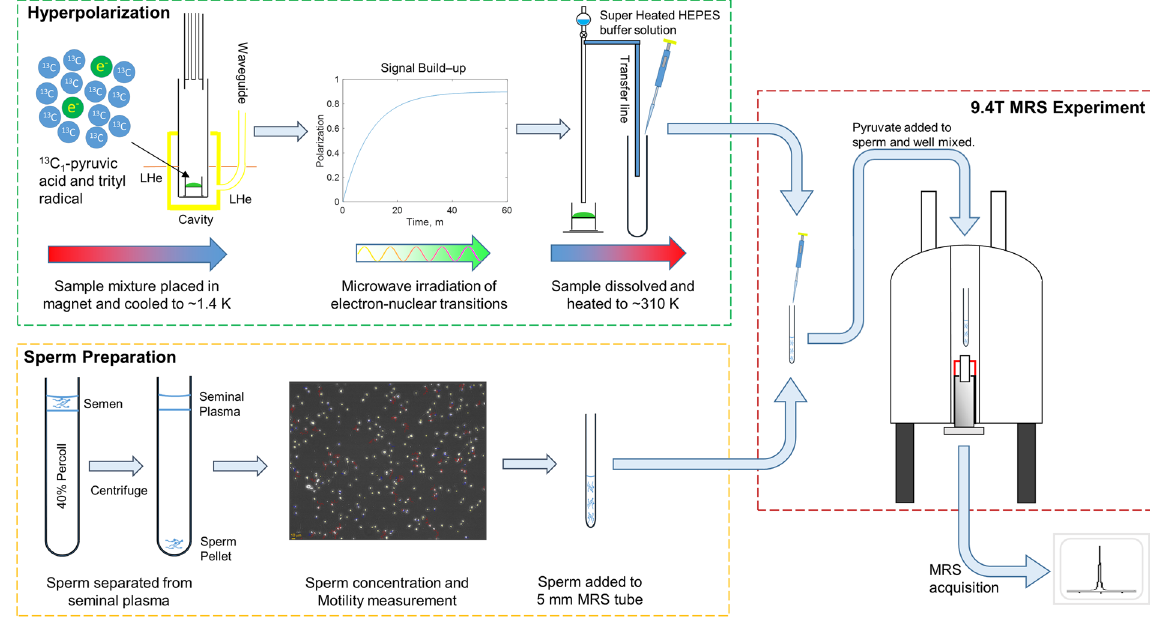
Figure 2. Outline of the methods used for administering hyperpolarized substrates to live sperm. The method consists of three parts, briefly: (i) Hyperpolarization, a mixture of pyruvate/trityl radical was cooled to 1.4 K and microwave for ~1 hour. Once the hyperpolarized 13 C 1 -pyruvate signal had built up, the sample was then rapidly dissolved with superheated HEPES buffer solution and returned to ~310 K; (ii) Sperm Preparation, the semen sample was layered on top of a denser Percoll solution and centrifuged. Sperm are pelleted at the bottom, with seminal plasma remaining at the top of the tube. After further washing, sperm are assessed for concentration and motility before being placed in an MRS tube; and (iii) MRS Experiment, quickly after the pyruvate sample was dissolved and collected, an aliquot was taken and injected into the MRS tube containing sperm and well mixed. The MRS tube was placed in the magnet and MRS scanning commenced. See Methods for more details.